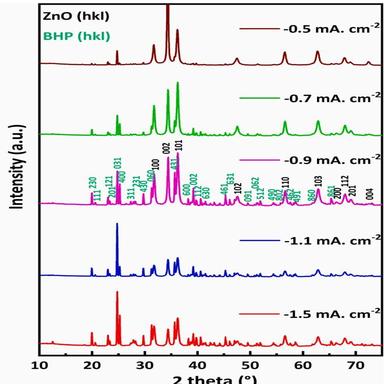
X-ray diffractograms of BHP deposited on ZnO at different current densities.